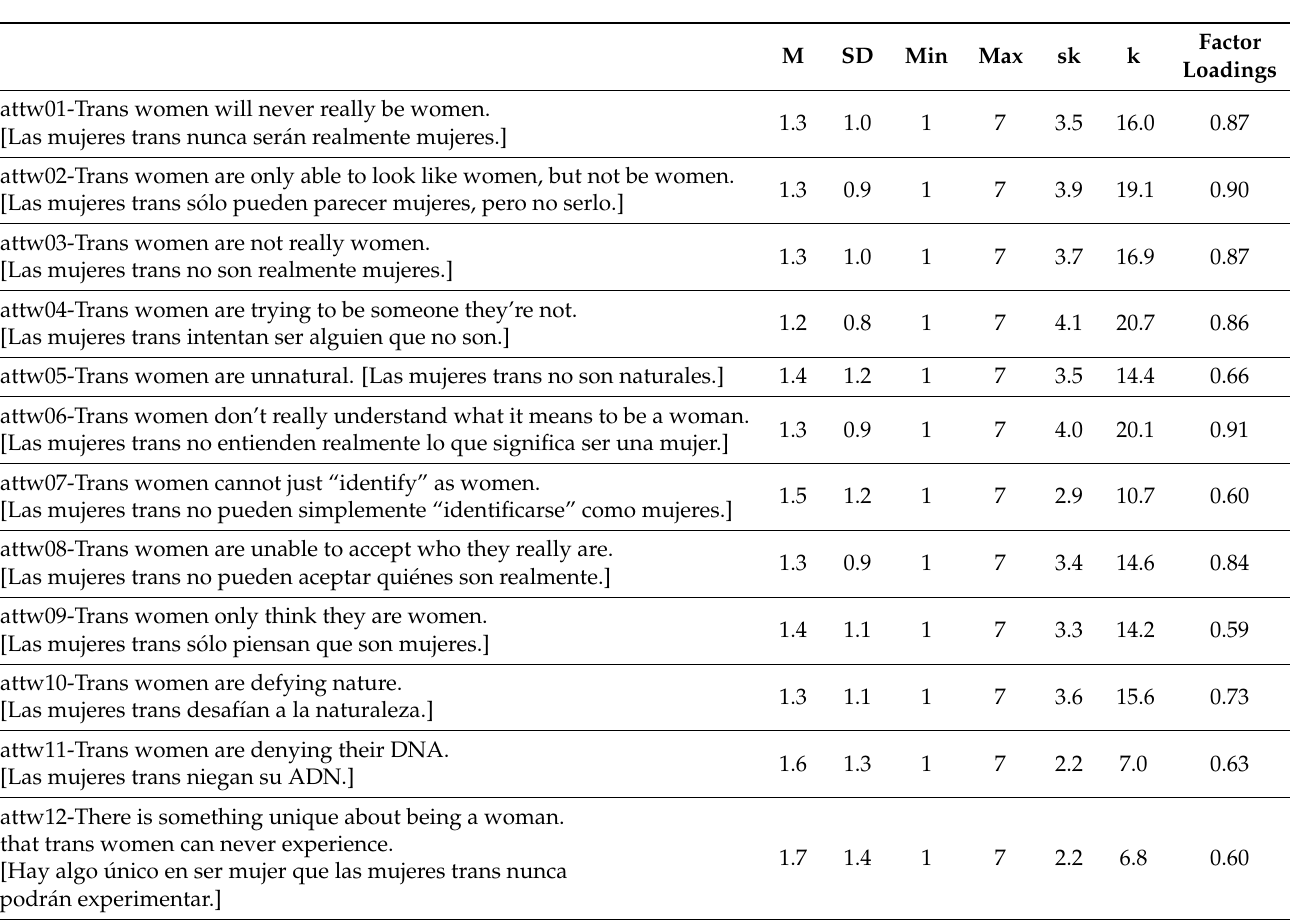
Table 2. ATTW Item Content, Descriptive Statistics, and Standardized Factor Loadings.